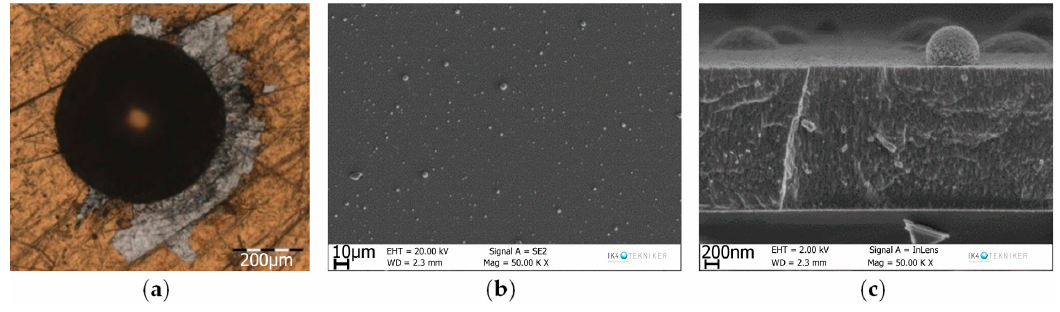
Figure 11. SEM images for D3 coating; ( a ) adhesion results; ( b , c ) D3 surface, and cross-section micrographs.